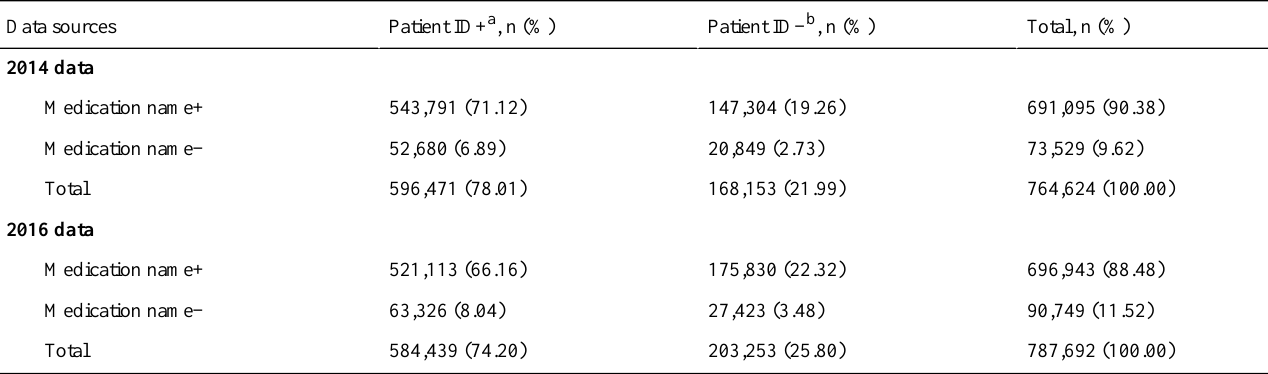
Table 1. The distribution of smart pump records with and without valid patient IDs and medication names.